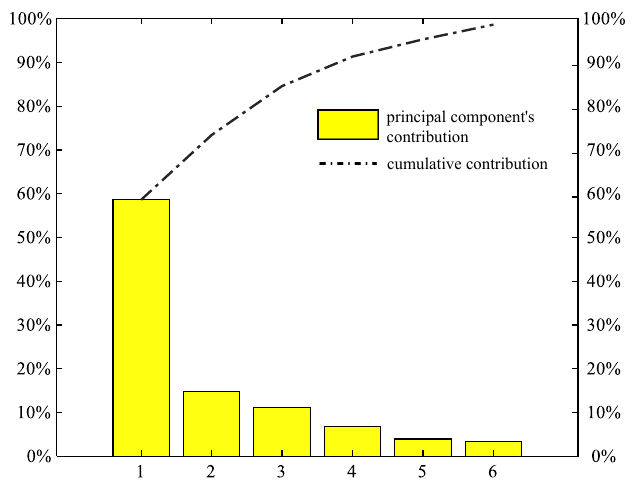
Figure 5. The cumulative contribution of first 6 principal Fig. 5. The cumulative contribution of first 6 principal components